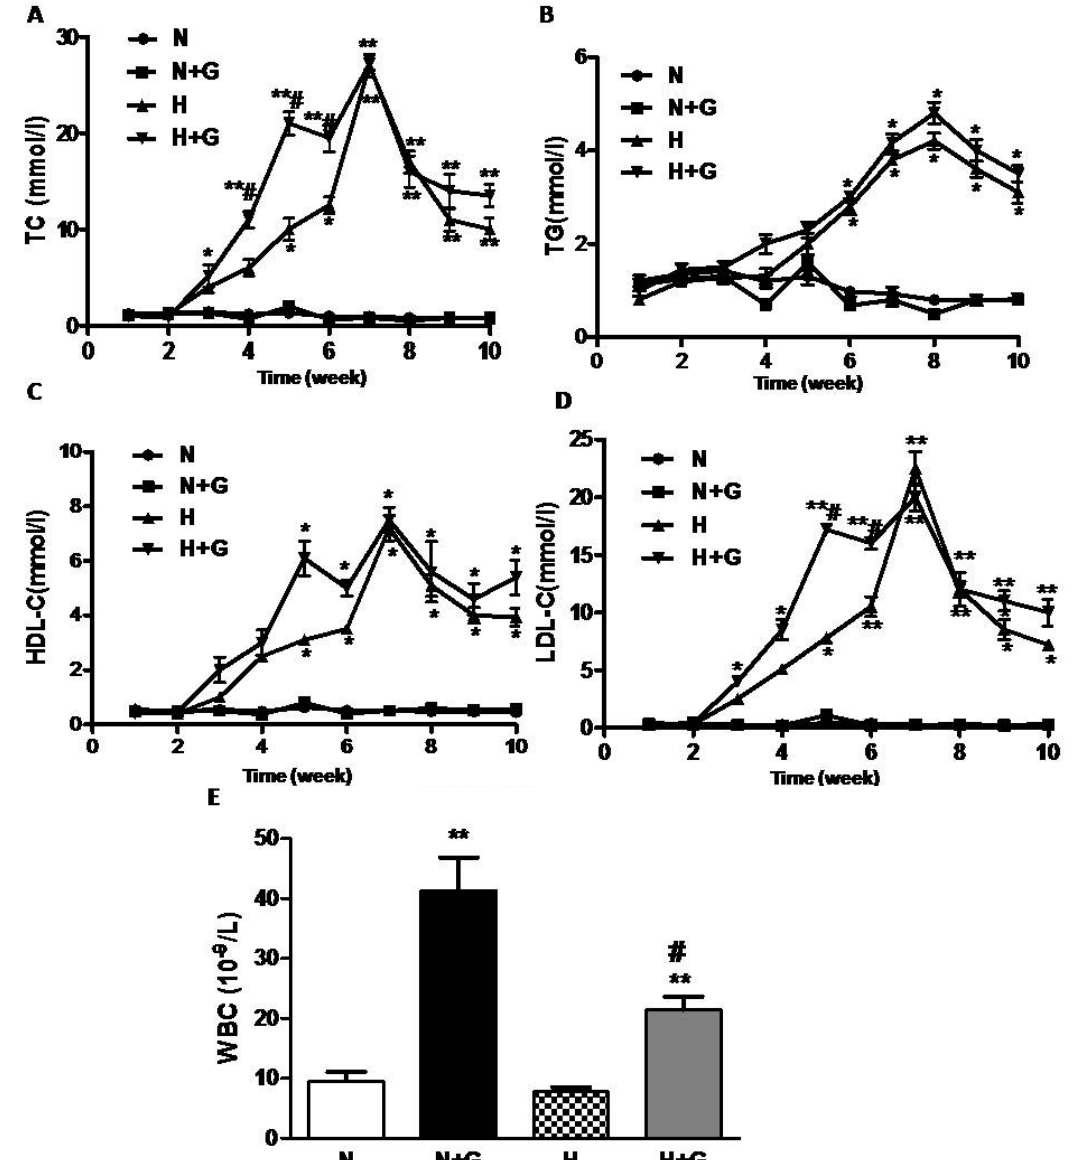
Figure 2. The changes of plasma lipids and the white blood cells (WBC) counts. ( A ) total cholesterol (TC) (mmol/L) ( B ) triglyceride (TG) (mmol/L) ( C ) low density lipoprotein-cholesterol (LDL-C) (mmol/L) ( D ) high cholesterol density lipoprotein-cholesterol (HDL-C) (mmol/L) N: normal diet group ( n = 5). ( E ) the WBC counts in blood. N + G: normal diet group treated with G-CSF ( n = 6), H: high-fat diet group ( n = 6). H + G: high-fat diet group treated with G-CSF ( n = 7). Results are expressed as means ± SEM. * p < 0.05, ** p < 0.01, normal diet +G-CSF vs. normal diet group, or high-fat diet +G-CSF vs. high-fat diet group; # p < 0.05 high-fat diet group vs. normal diet group